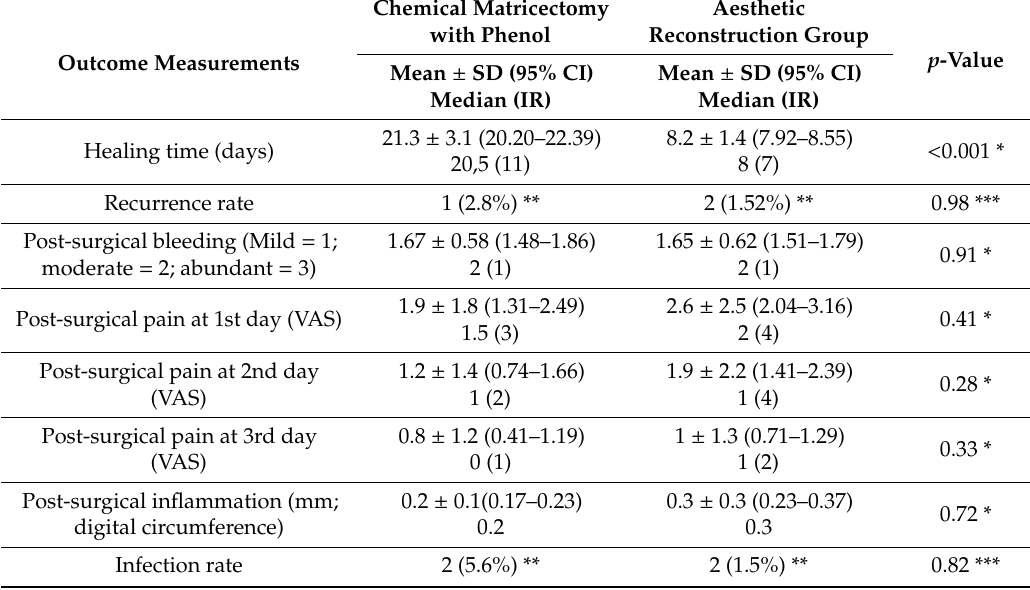
Table 2. Comparisons for outcome measurements between both treatment